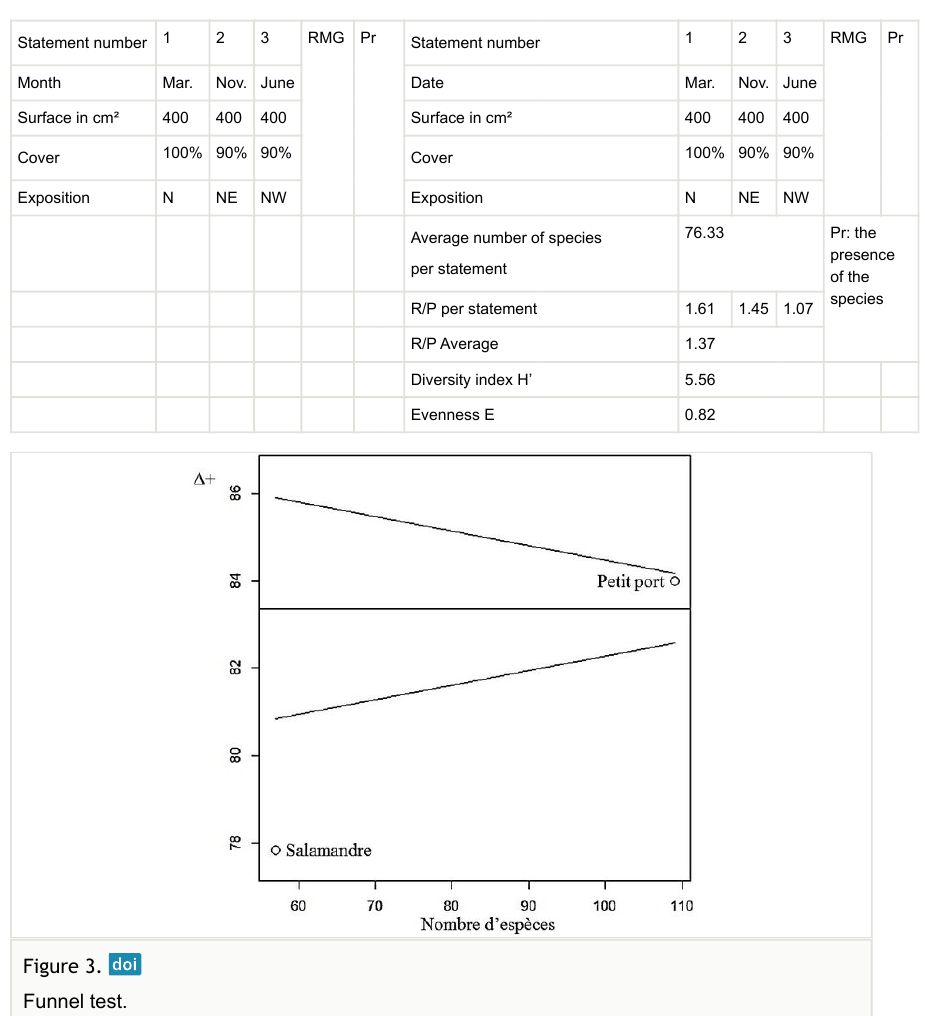
Figure 3. Funnel test.